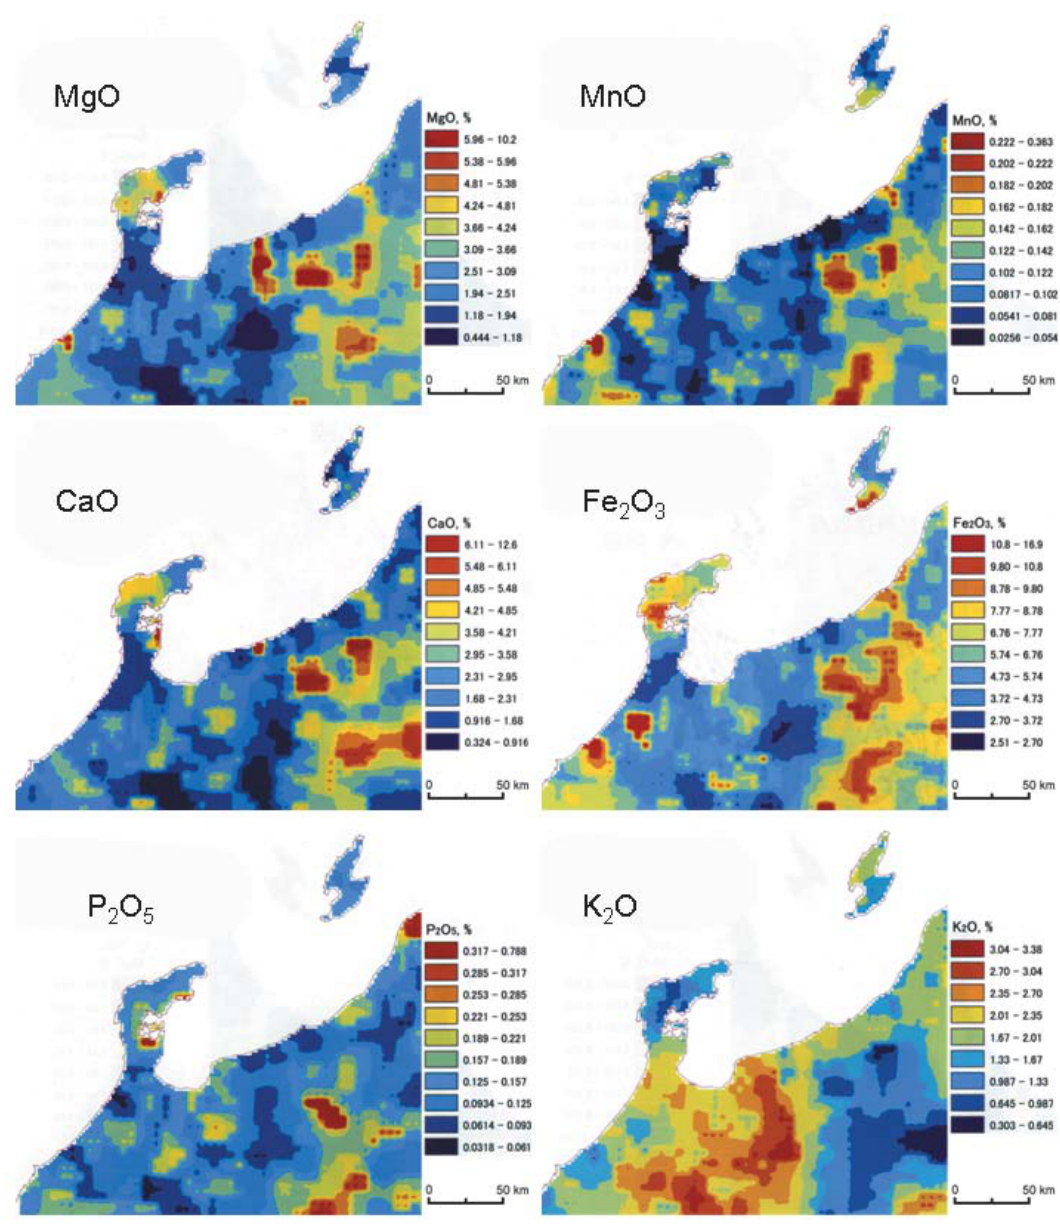
Fig. 4 – Geo-chemical maps of river sediments at Hokuriku district, Japan. River sediments were used for the chemical analyses (Geological Survey of Japan 2004; open to the